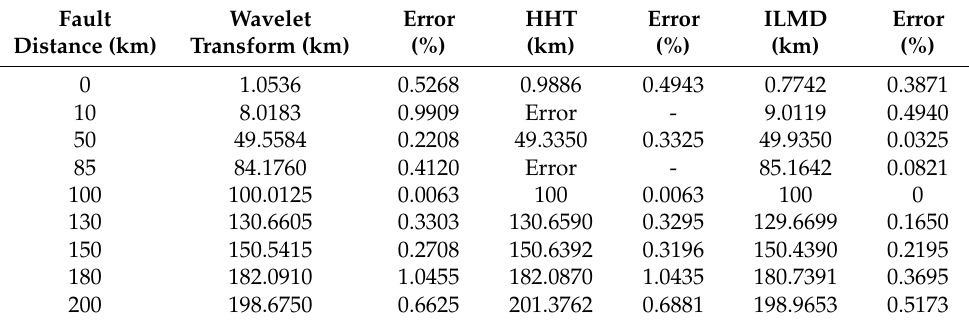
Table 1. Comparison of ILMD and other ranging methods.